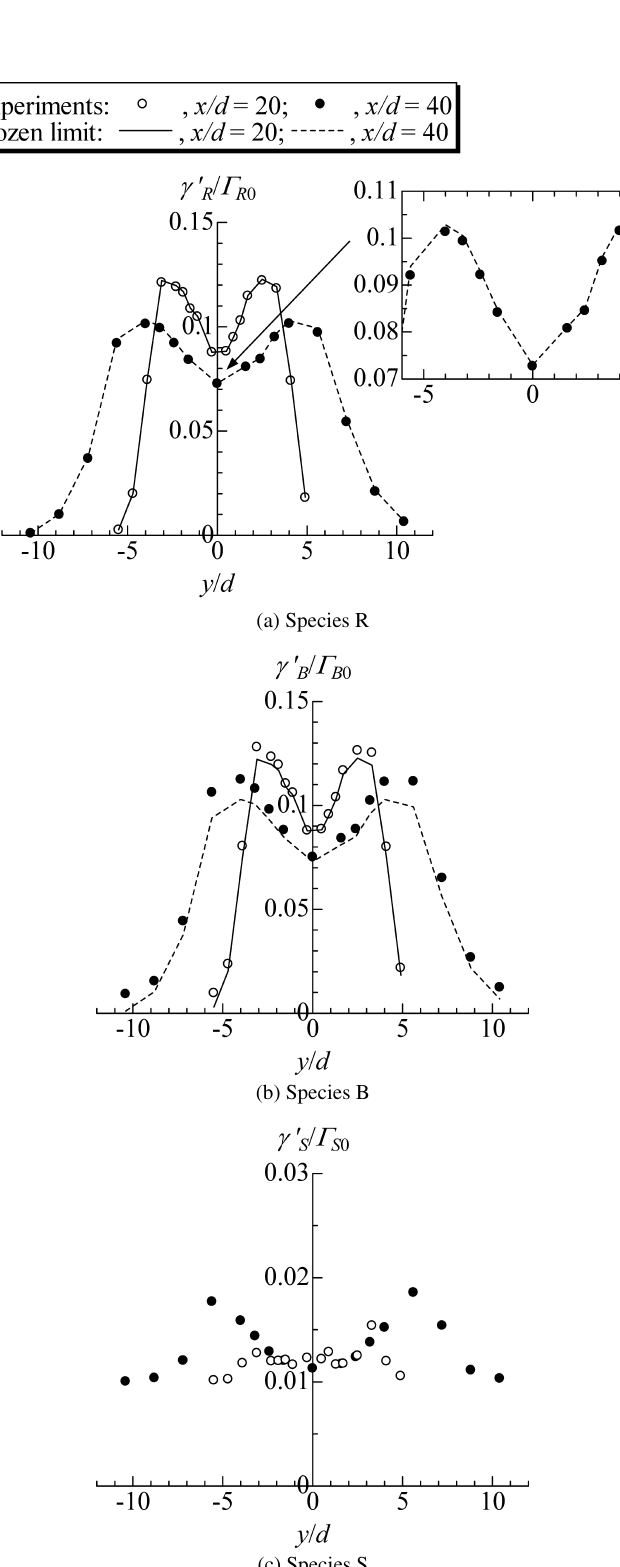
Fig. 7 Cross-streamwise profiles r.m.s. value of concentration